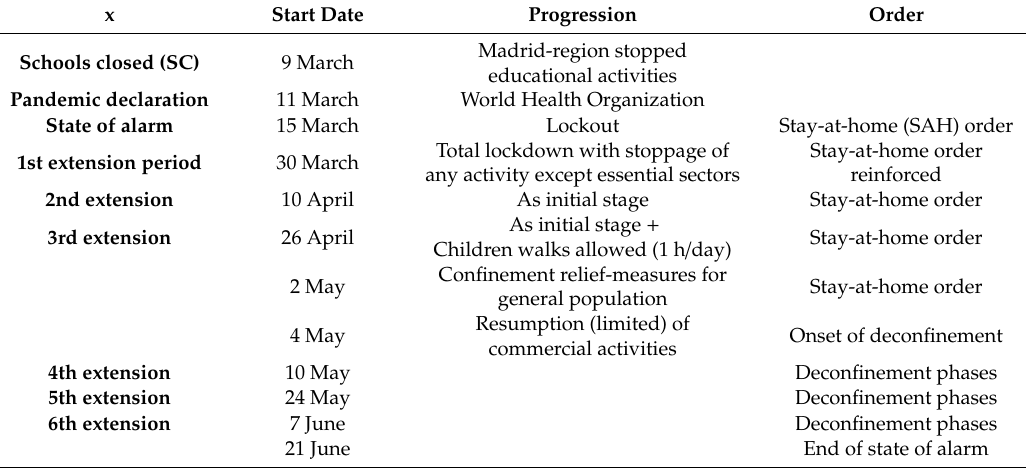
Figure 1. Chronology and periods of the state of alarm in Spain in 2020. Table 1. Chronology situation of the confinement in homes in Spain in